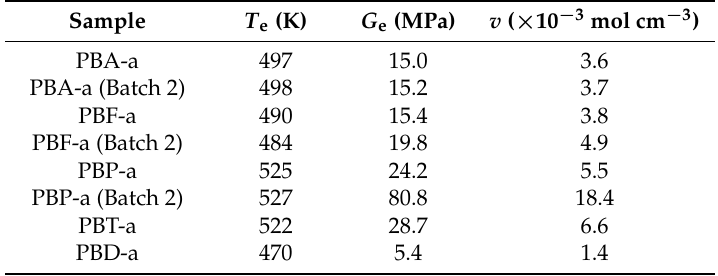
Table 5. Crosslink density calculated from DMTA